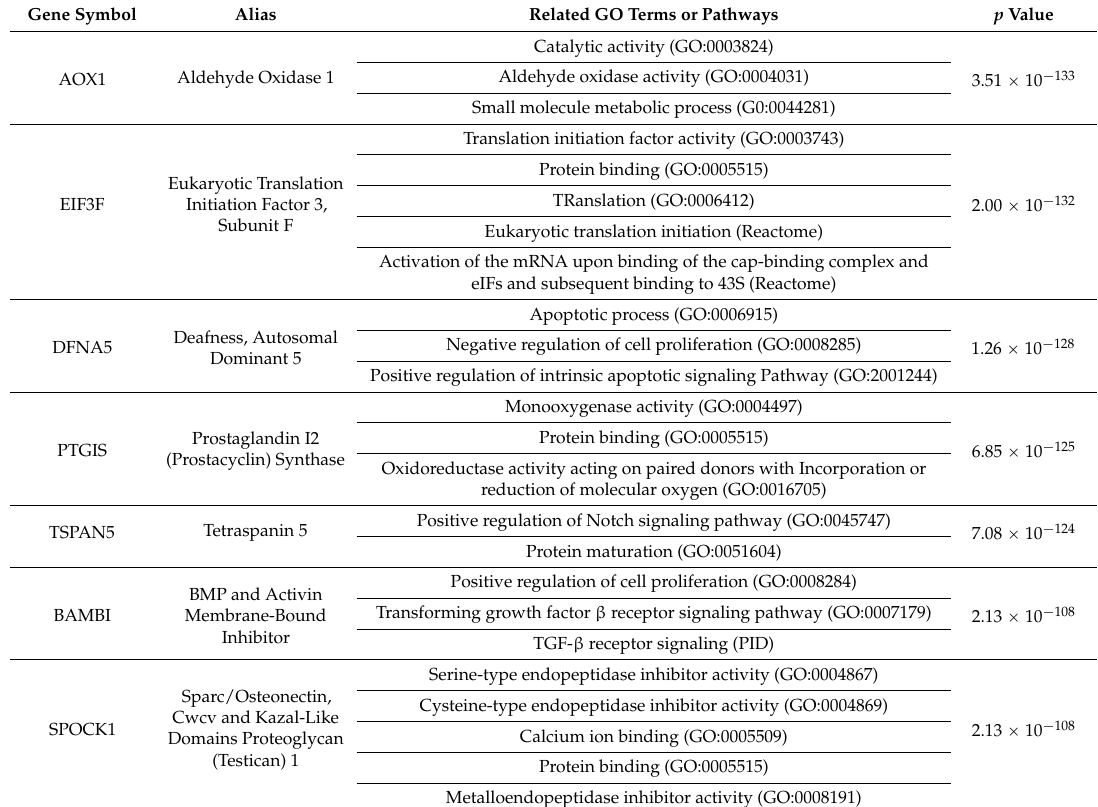
Table 5. Top 10 down-regulated differentially expressed genes for serous